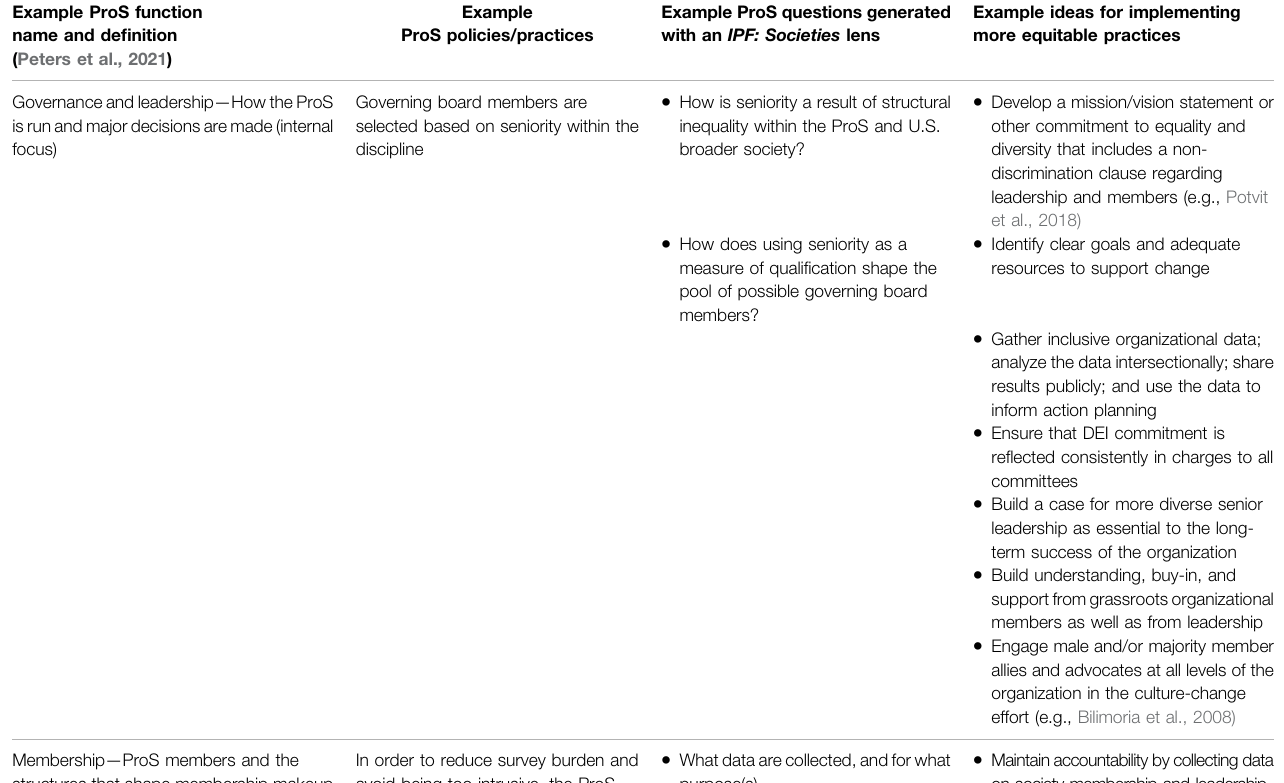
TABLE 1 | How the IPF: Societies informs practices within fi ve example professional society functions. Example ProS function name and de fi nition (Peters et al.,